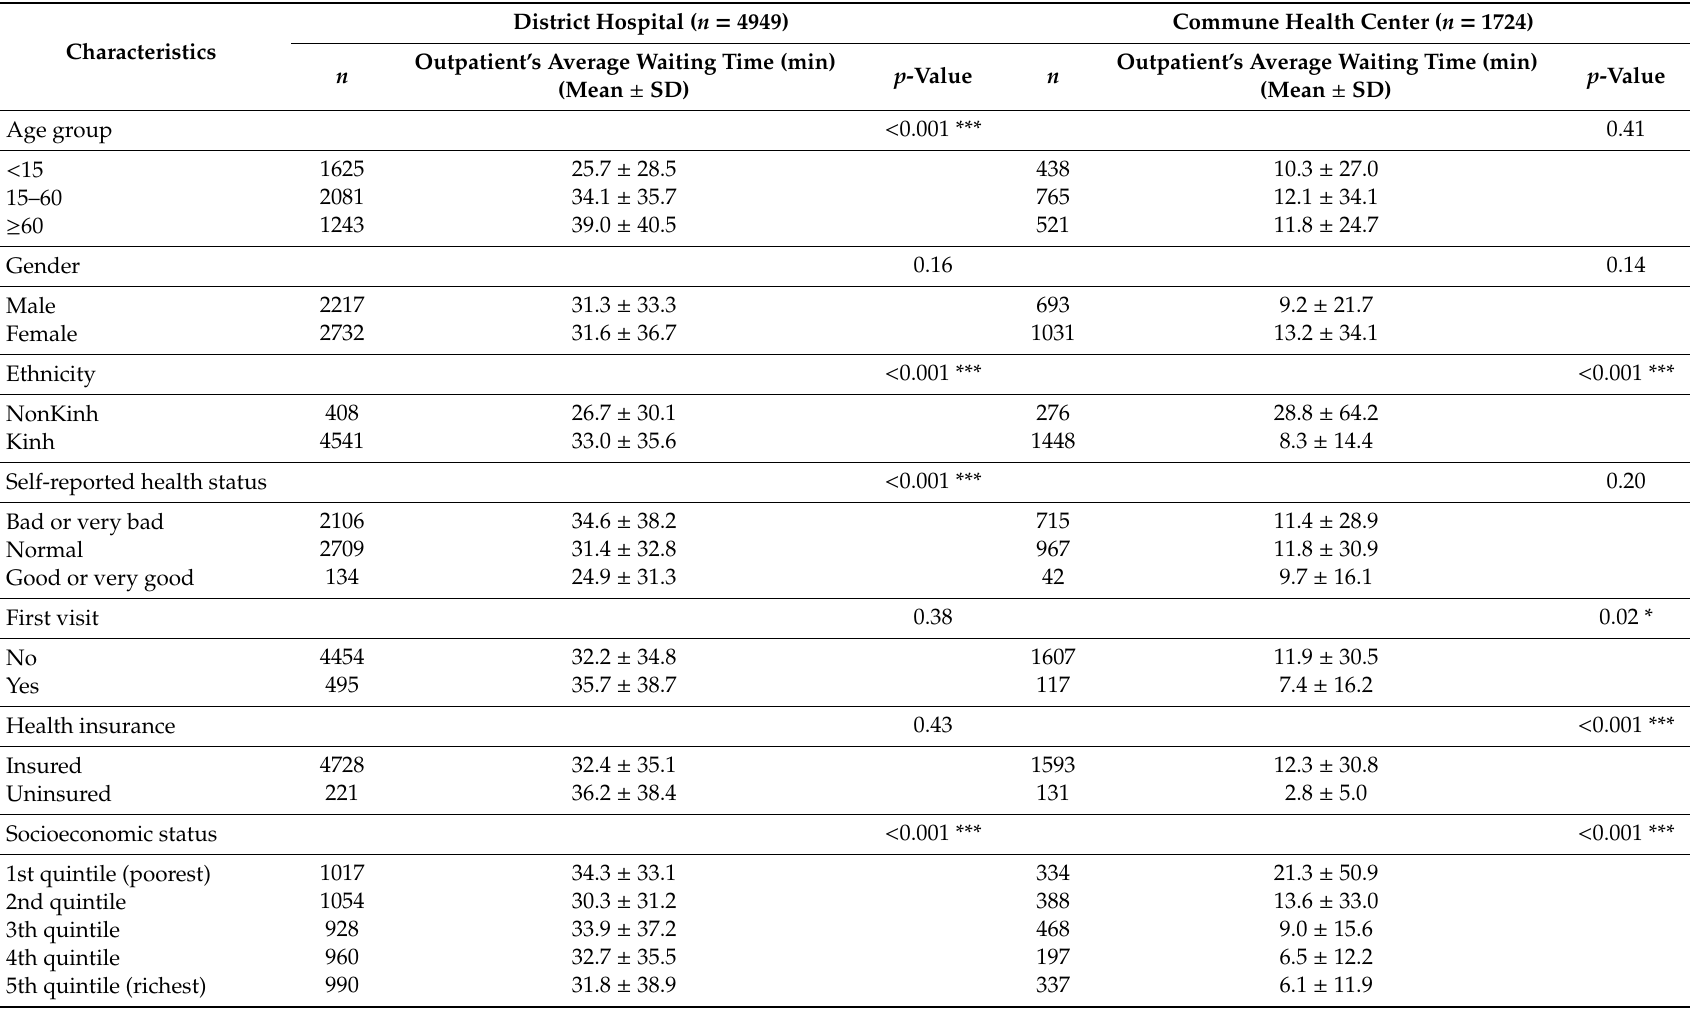
Table 1. Average outpatient waiting time according to selected socioeconomic characteristics grouped by health